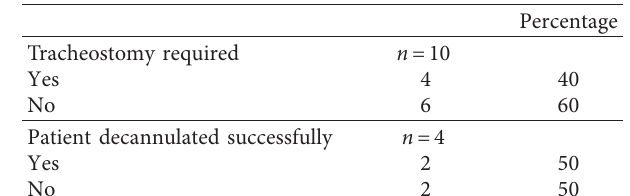
Table 4: Decannulation